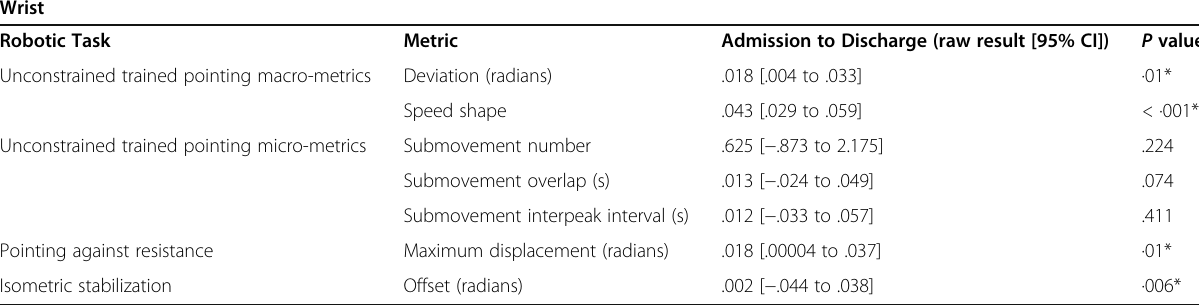
Table 5 Significant changes from admission to discharge for the combined analysis of wrist kinematic data Wrist Robotic